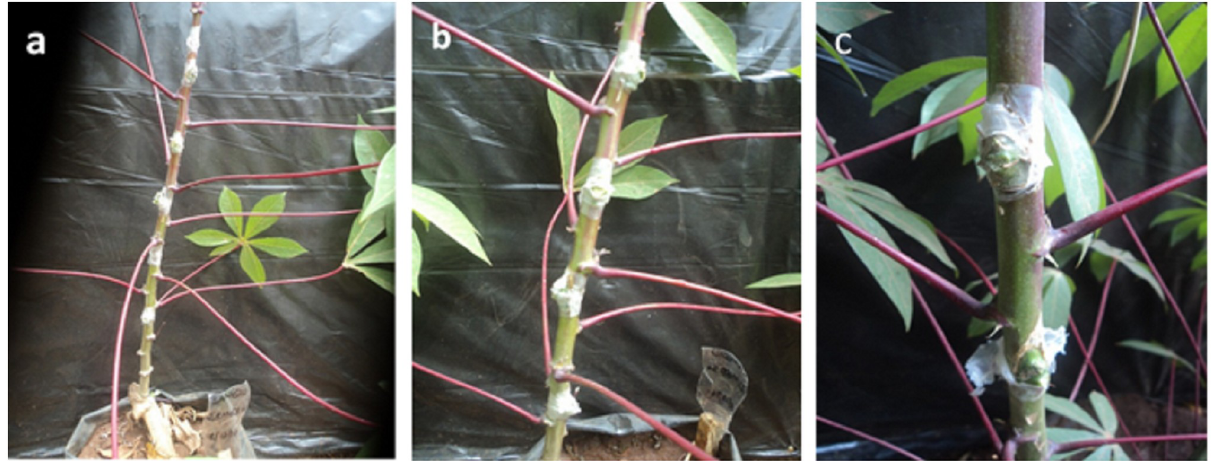
Fig 2. Cassava plants of BEN86052 inoculated by grafting. Six buds ( a ), four buds ( b ), and two buds ( c ).